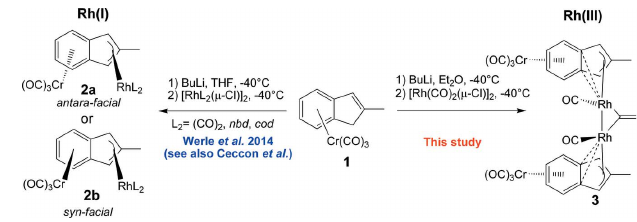
Figure 1 Reaction